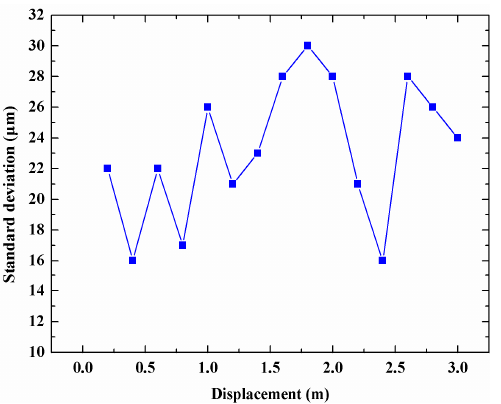
Figure 6. Measurement standard deviation at different displacements.